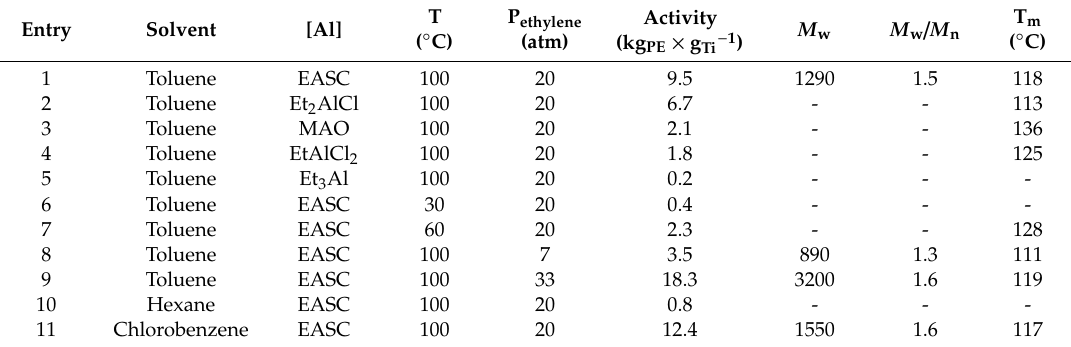
Table 5. E ff ect of the reaction conditions on the ethylene polymerization promoted by 15